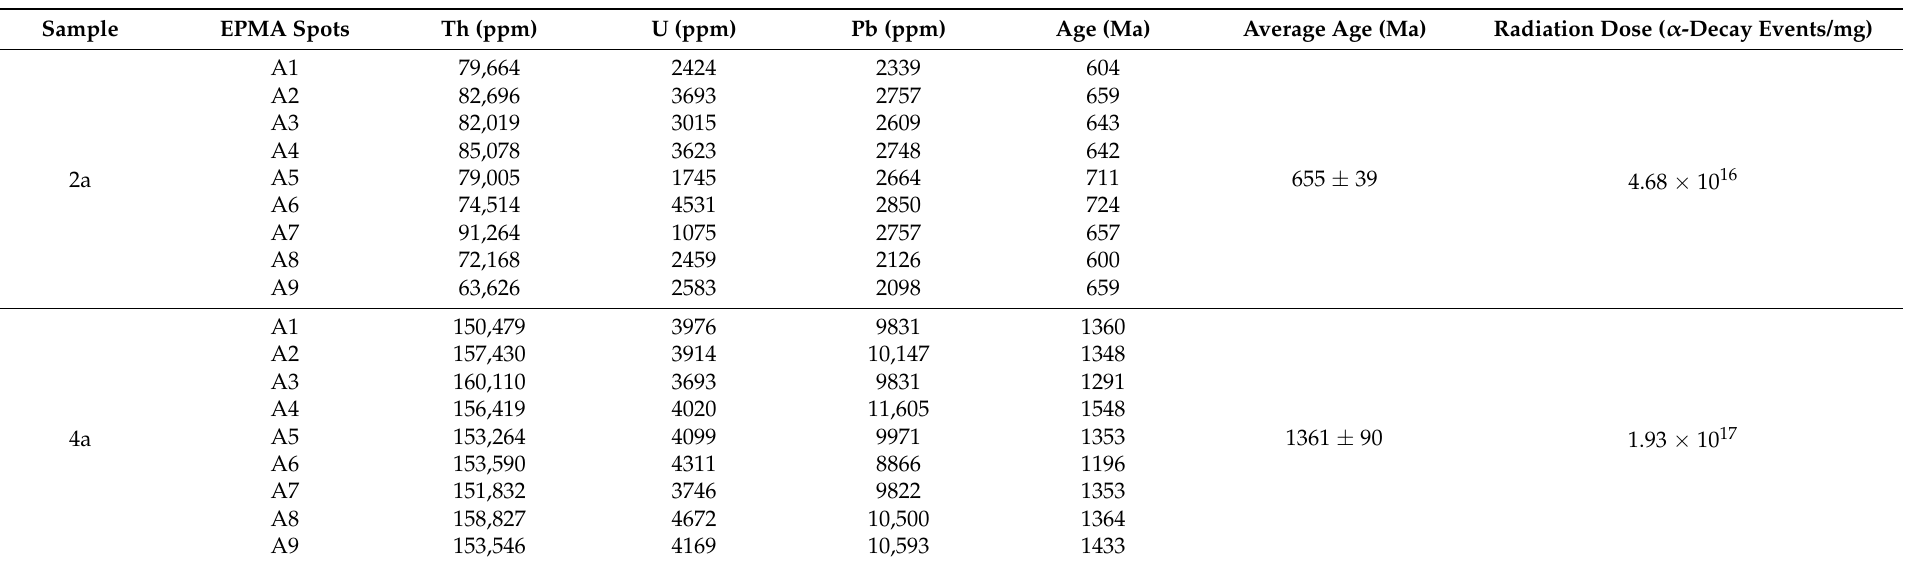
Table 5. Concentrations of U, Th, and Pb, chemical age, and α -radiation doses for samples 2a and